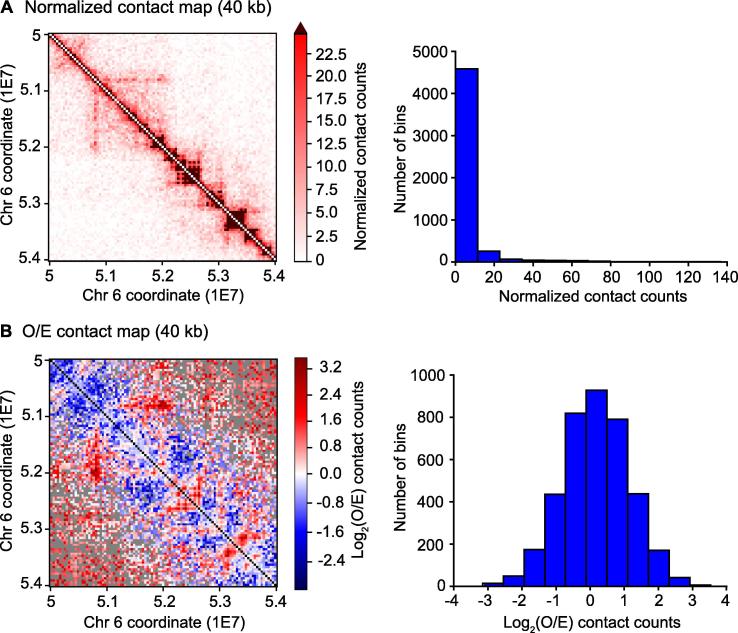
Contact heatmaps for chromosome 6: [50–54] Mb at the 40-kb resolutionA. Normalized contact matrix, where each entry contains the corrected contact count. The upper limit of the colormap is the 95th percentile of the contact counts and values above this limit are represented in brown in the heatmap. Using an upper cut-off for the contact counts allows to emphasize local chromatin structures (TADs and sub-TADs) over the background. The histogram displays the normalized contact count distribution. Values on the X axis indicate the number of contacts, while values on the Y axis indicate the frequency of the bins in the contact matrix with the corresponding contact count on the X axis. The number of contacts ranges from 0 to 137. B. O/E contact matrix, where each entry contains the log2 of the O/E contact counts, considering the linear distance between loci and the learned correction parameters. Loci without expected contacts and loci without observed contacts are indicated with black and gray pixels, respectively. The histogram displays the O/E contact count distribution in log2-transformed form, ranging from −3.153 to 3.530. O/E, observed over expected.